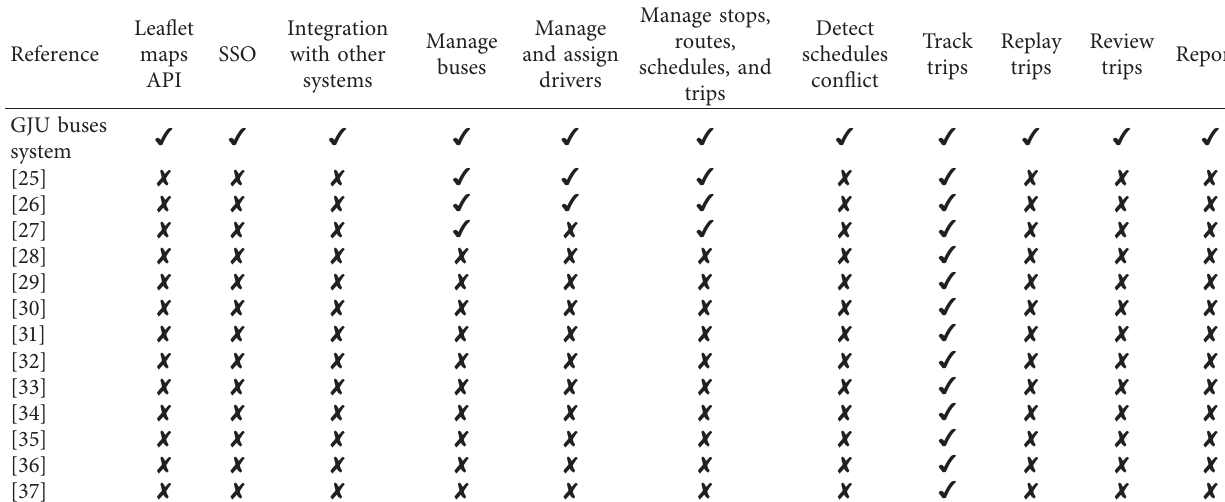
Table 3: A feature comparison to related